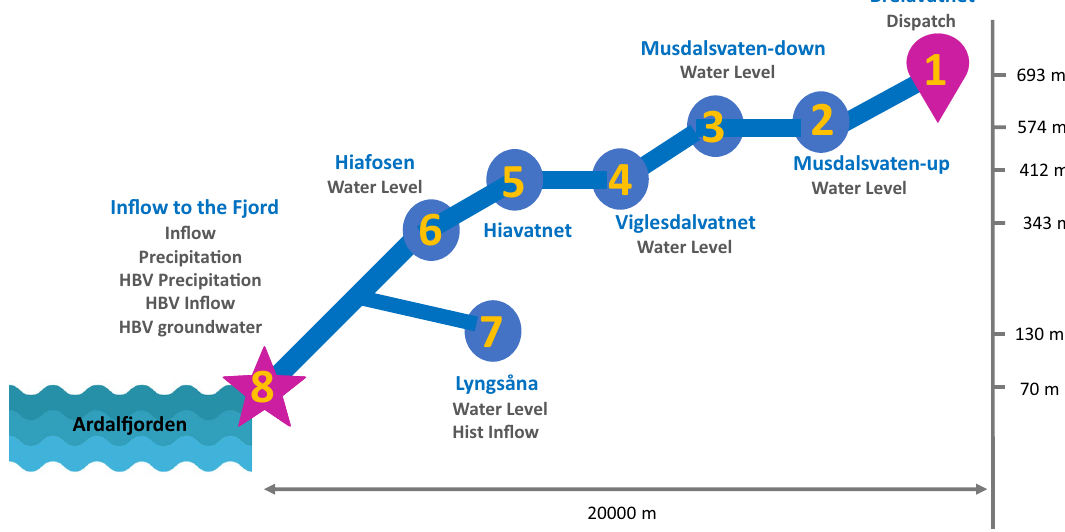
Figure 9. Geo-spatial relationship between selected causal candidates by using the CVD.